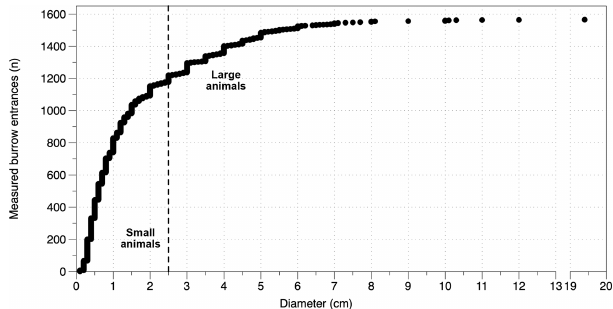
Figure 9. Number of measured entrances sorted by diameter. The dashed vertical line indicates the 2.5cm diameter value of classi- fication between small animals and large animals. n total = 1565; n small animal = 1177; n large animal =